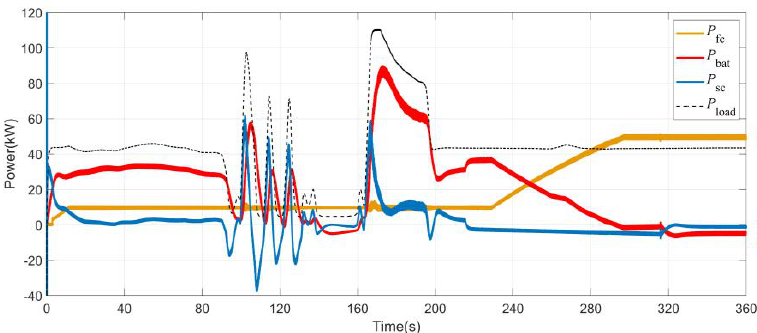
Figure 24. Power curve plot with the improved vessel energy management strategy.